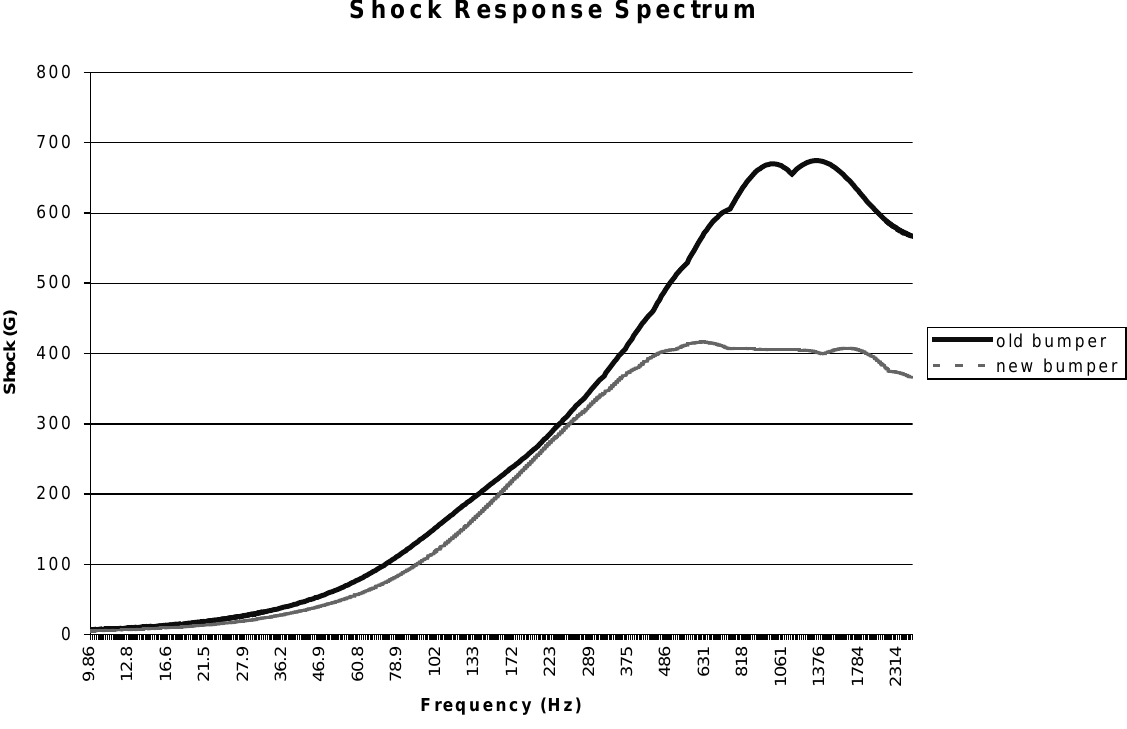
Fig. 12. Shock response spectrum (SRS) for old and new shock